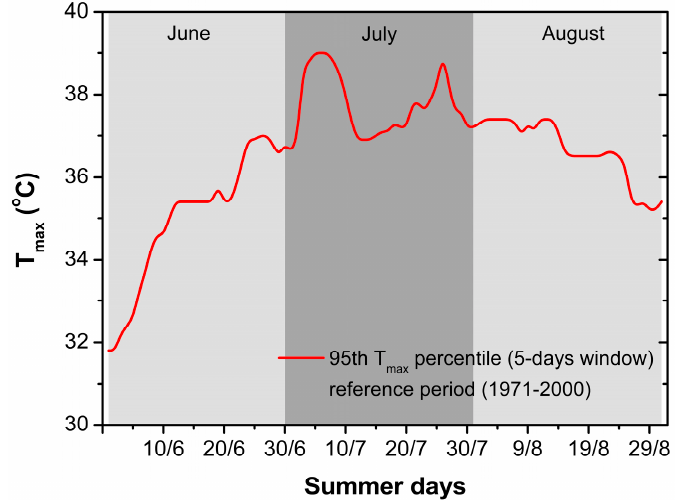
Figure 1. The 95th T max percentile-based thresholds on each calendar day of summer over the reference period (1971–2000). The 95th percentile of the reference period was computed from five-day windows producing a sample size of 150 values (30 years × 5 days) centered on each calendar day.